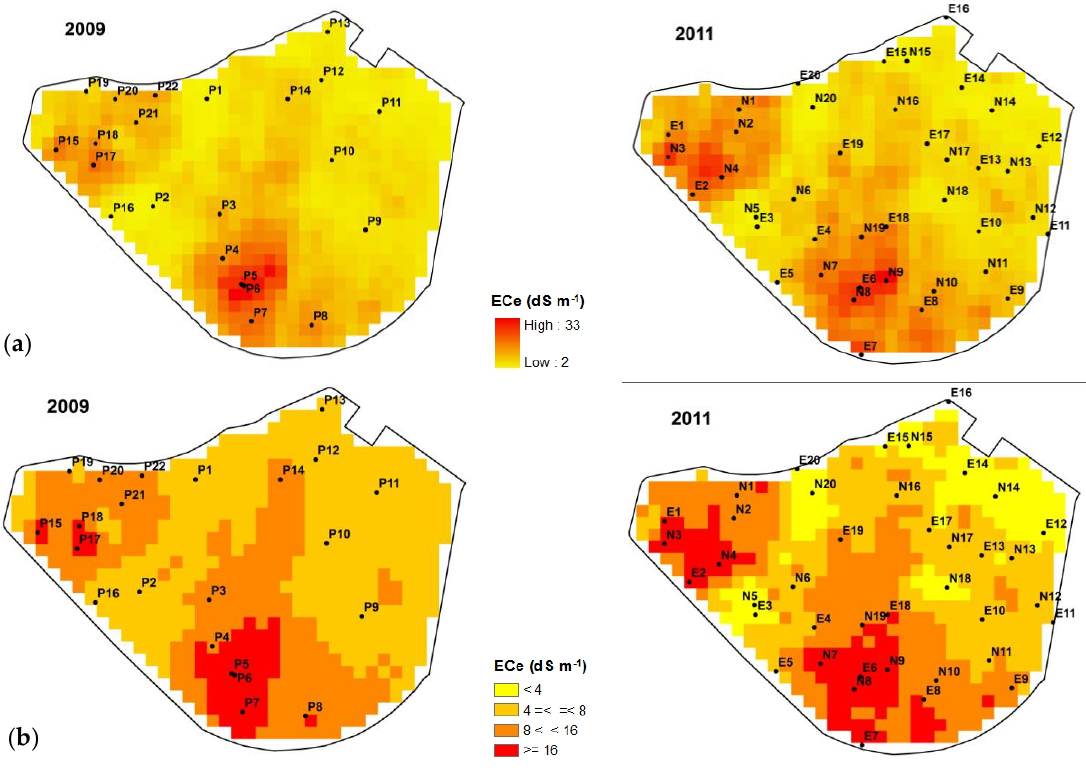
Figure 4. Salinity maps ( a ); and their classification in four saline phases ( b ) for each year studied.